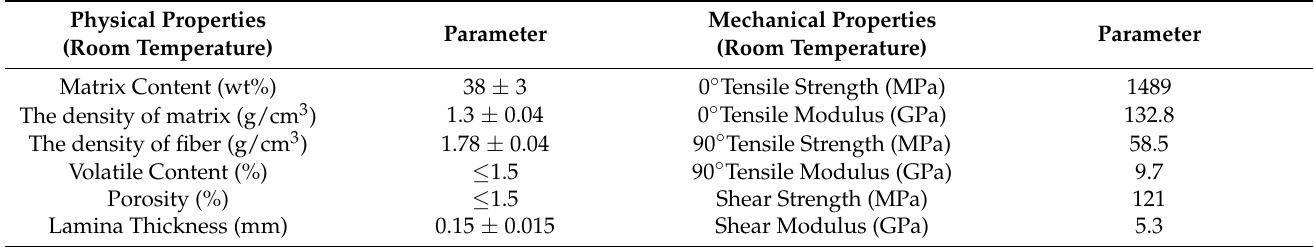
Table 1. The main physical and mechanical properties of the T700/BA9916 CFRP plates.